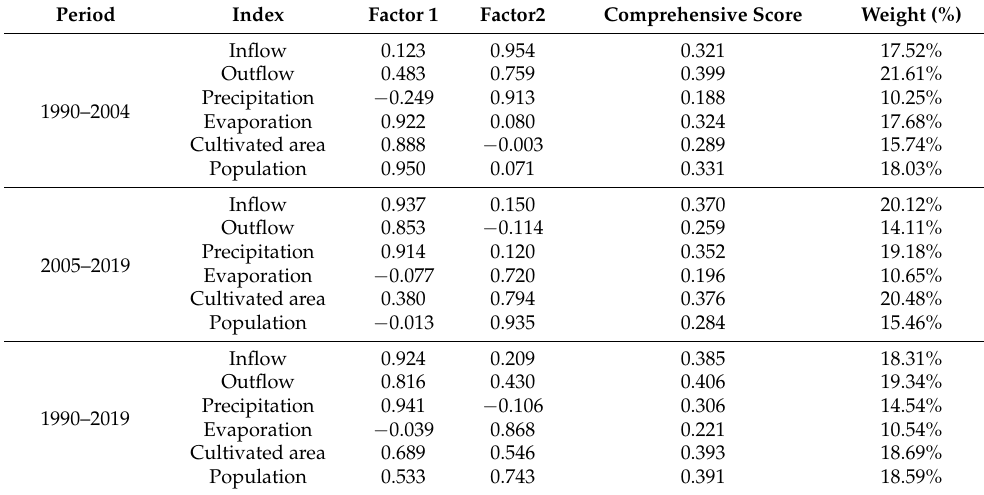
Table 3. Factor load matrix and index weighting at different